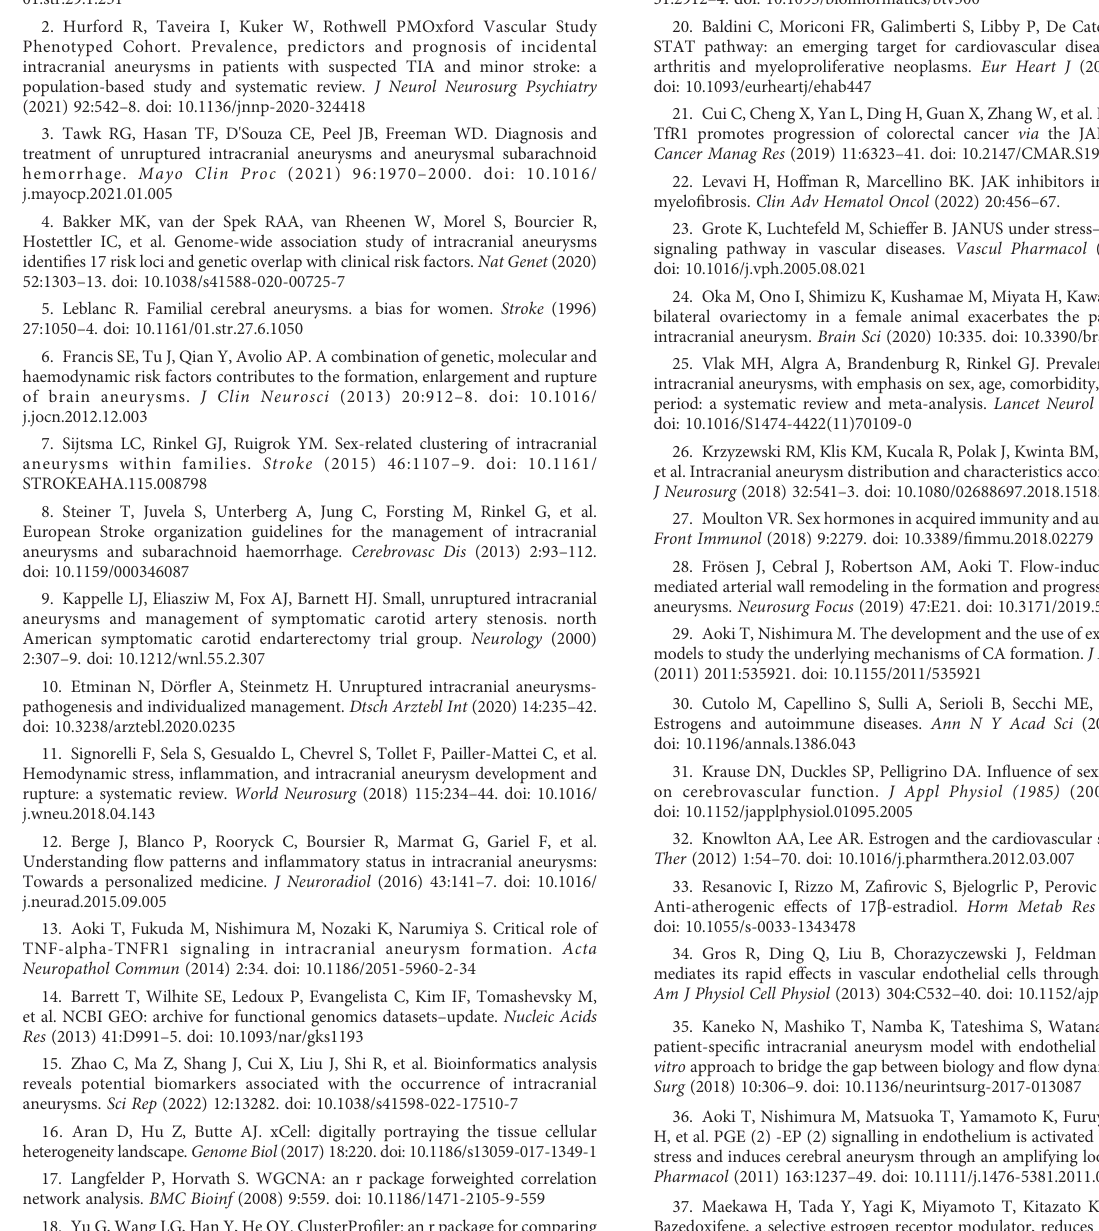
SUPPLEMENTARY FIGURE 2 Discrimination ability of the six characteristic genes of the estrogen response pathway (ERP) and cell type enrichment result from xCell (A)